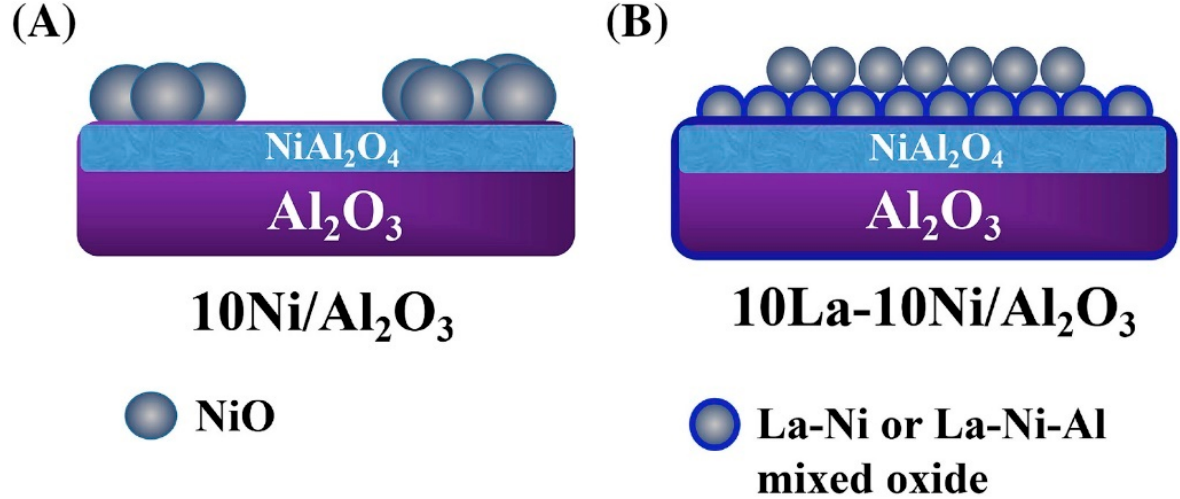
Figure 2. Effect of La addition ( B ) on the surface composition of a NiO supported on Al 2 O 3 catalyst ( A ). Reprinted with permission from Ref. [61]. Copyright 2022 Elsevier.